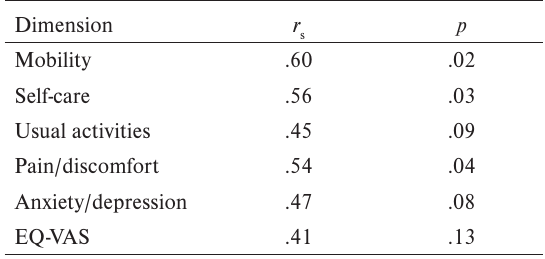
Pre and post-intervention correlations of EQ-5D dimensions Dimension r